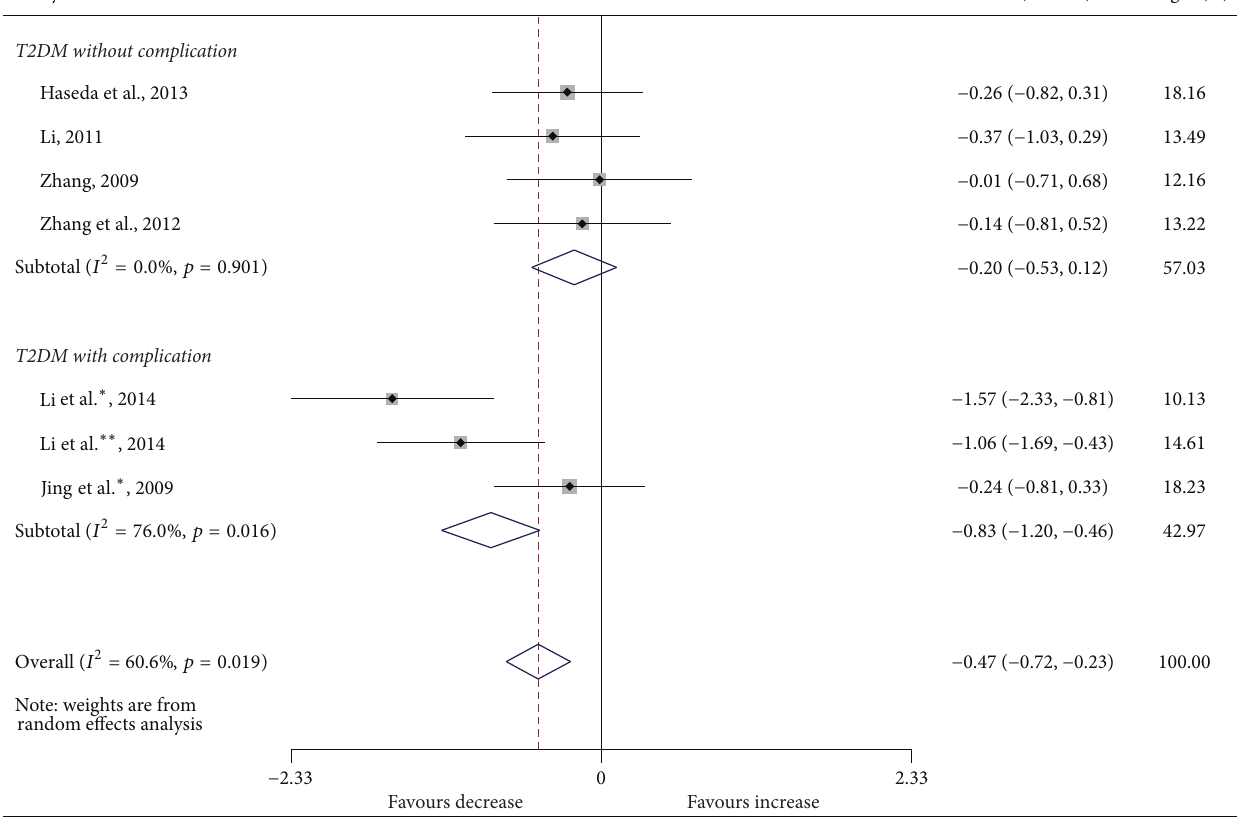
Figure 5: Forest plots for the frequency of CD4 + CD25 + Foxp3 + Treg in T2DM patients and controls with random effects model (T2DM without complication, 𝑝 = 0.211 ; T2DM with complication , 𝑝 < 0.001 ; overall, 𝑝 < 0.001 ). ∗ T 2 DM with complication. ∗∗ T 2 DM with different